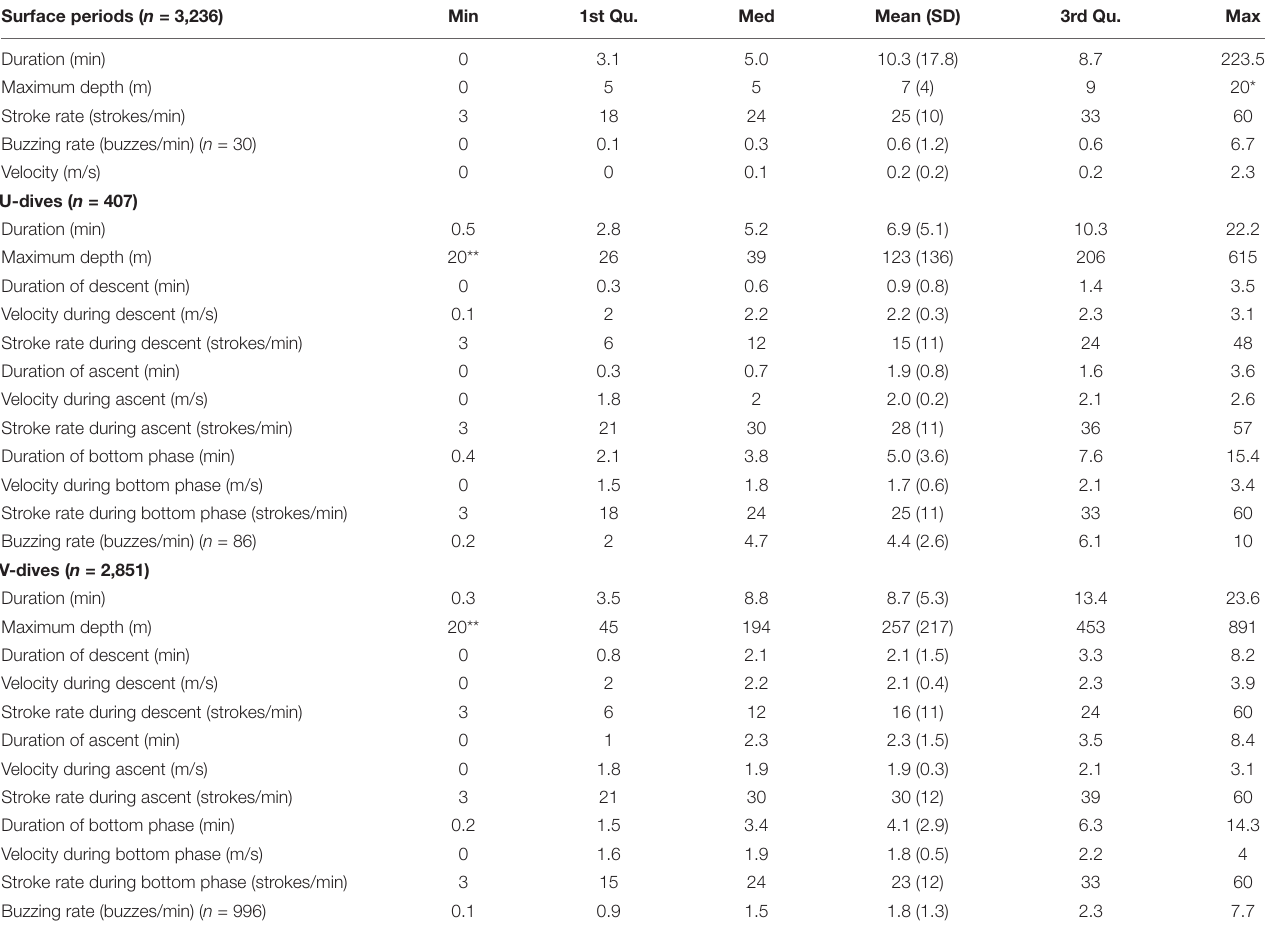
TABLE 2 | Summary statistics for dives ( n = 3,258) and surface periods ( n = 3,236). Surface periods ( n = 3,236) Min 1st